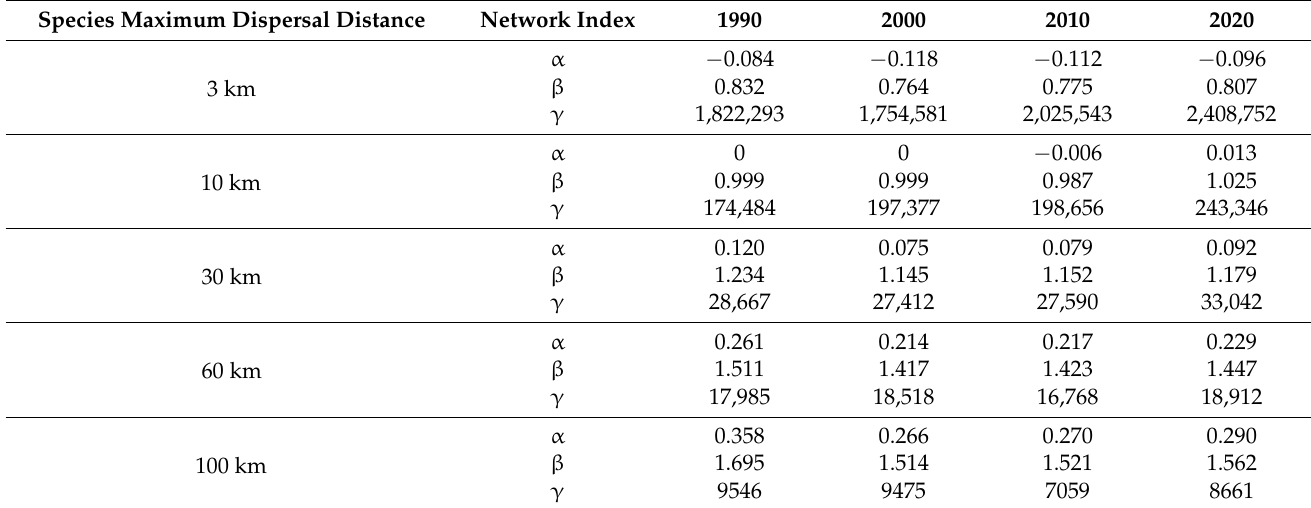
Table 3. Changes in α , β and γ indices from 1990 to